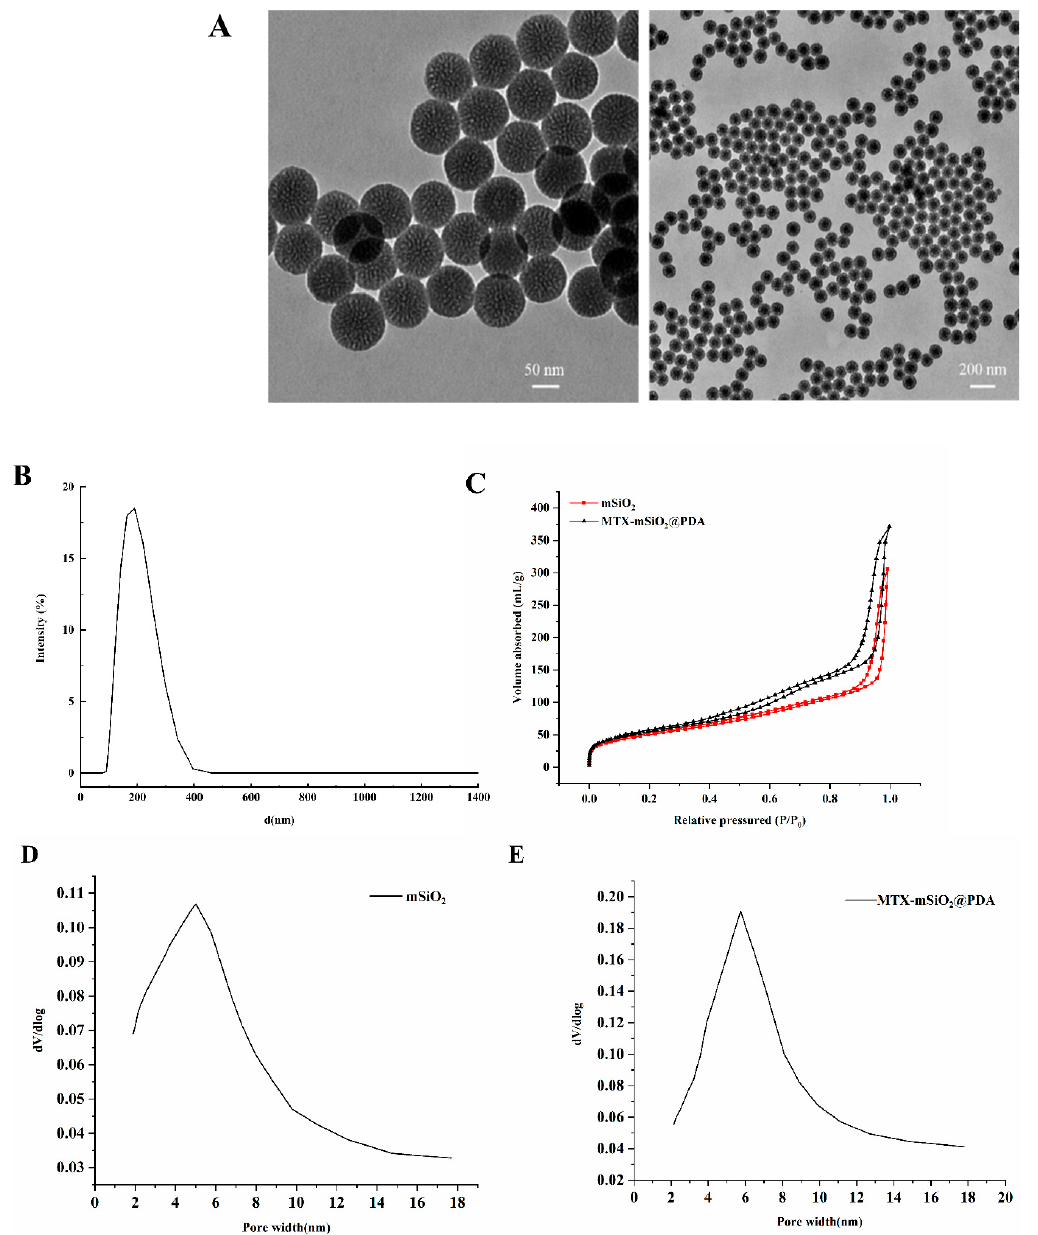
Figure 1. Synthesis of mSiO 2 and MTX-mSiO 2 @PDA. ( A ) TEM images of mSiO 2 ; ( B ) DLS size distribution of mSiO 2 ; ( C ) BET of mSiO 2 and MTX-mSiO 2 @PDA; ( D ) pore size distribution curves of mSiO 2 ; ( E ) pore size distribution curves of MTX-